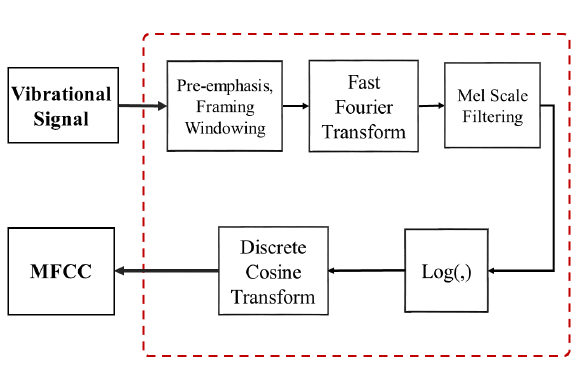
Figure 2. MFCC feature extraction